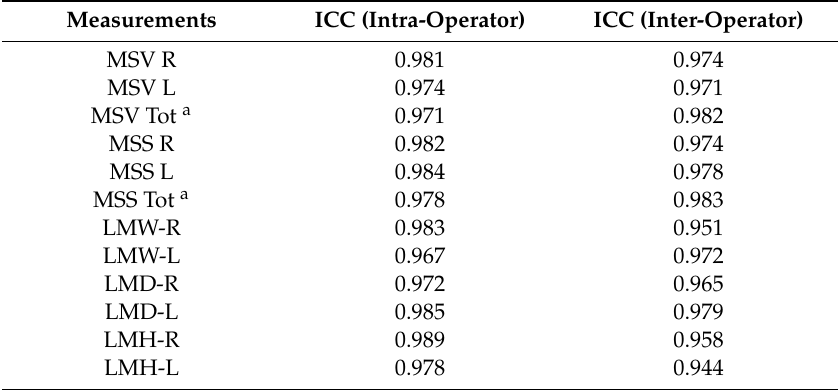
Table 4. Intra-operator and inter-operator agreement for maxillary sinus measurements. Measurements ICC